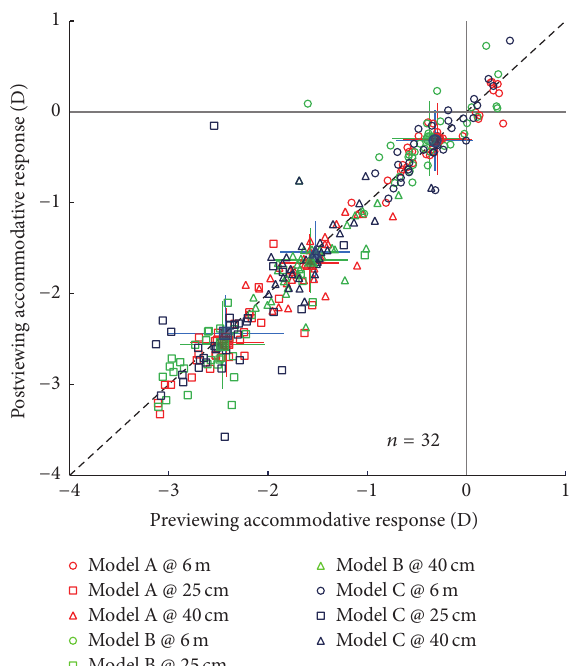
Figure3:Theeffectofa90-minute3Dviewingsessiononaccommodativeresponse.Thepostviewingaccommodativeresponsesofindividuals are plotted as open points as a function of their previewing accommodative responses for the three illumination modes, which were measured at distances of 25 cm, 40cm, and 6m. The average values of the accommodative responses are plotted as solid points (the mean ± SD). The dashed line is the identity line ( 𝑋 = 𝑌 ).